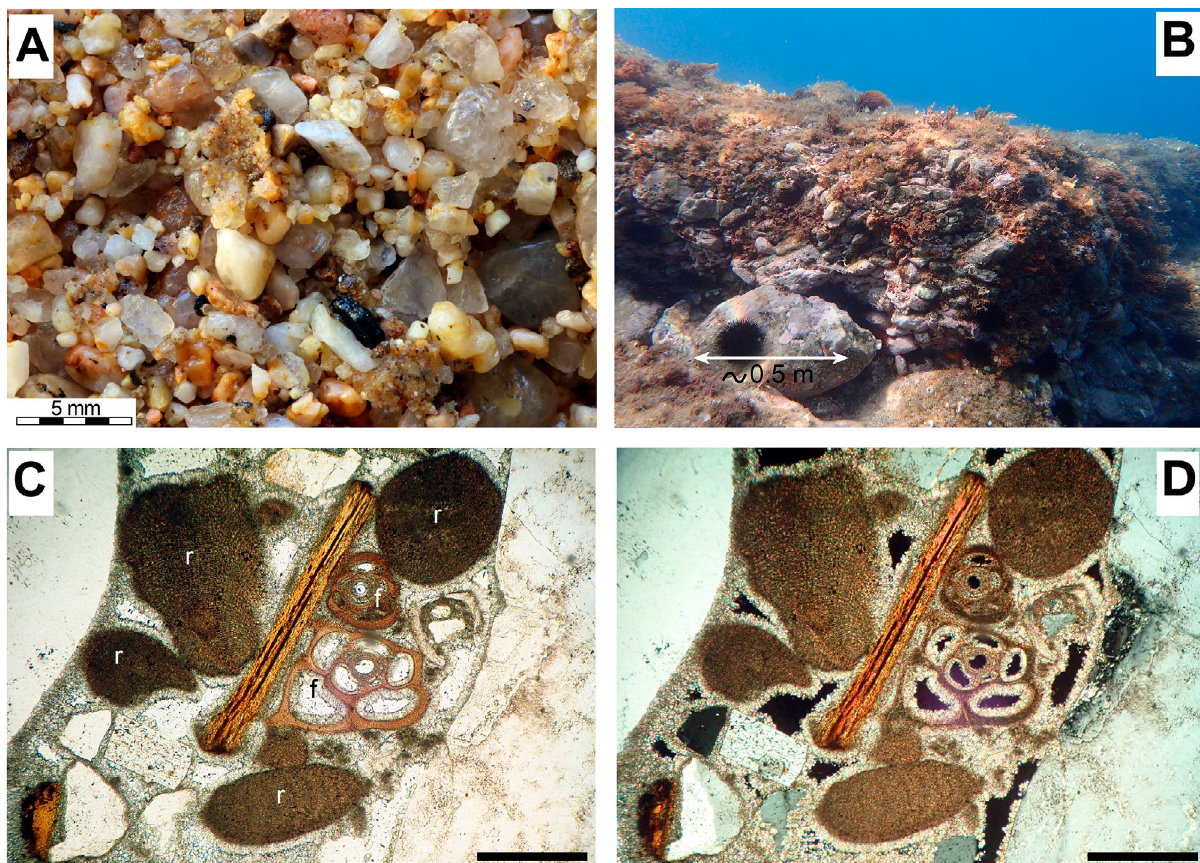
Fig. 6. – Petrological features. A, close-up image of a typical beachrock sample from the study area, constituted by very fine to medium gravel with a very coarse sand matrix (CA3). B, cemented very coarse gravels with rounded boulders at the base of the deposit (CA1). C, Thin section micrographs from the CA6 beachrock sample: f, foraminifera; r, coralline algae (left, plane polarized light; right, cross polarized light. Scale bar 0.25